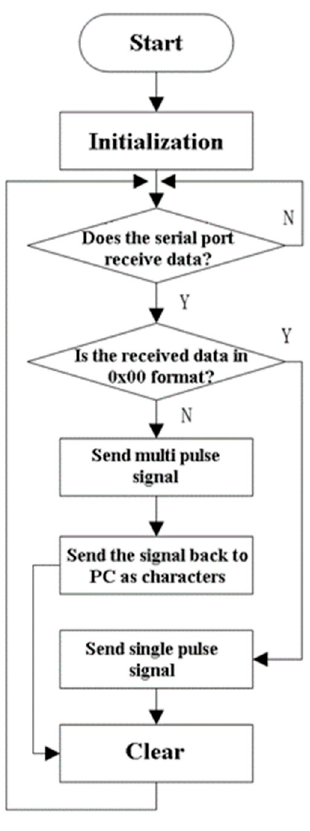
Figure 9. Flow chart of main software program.